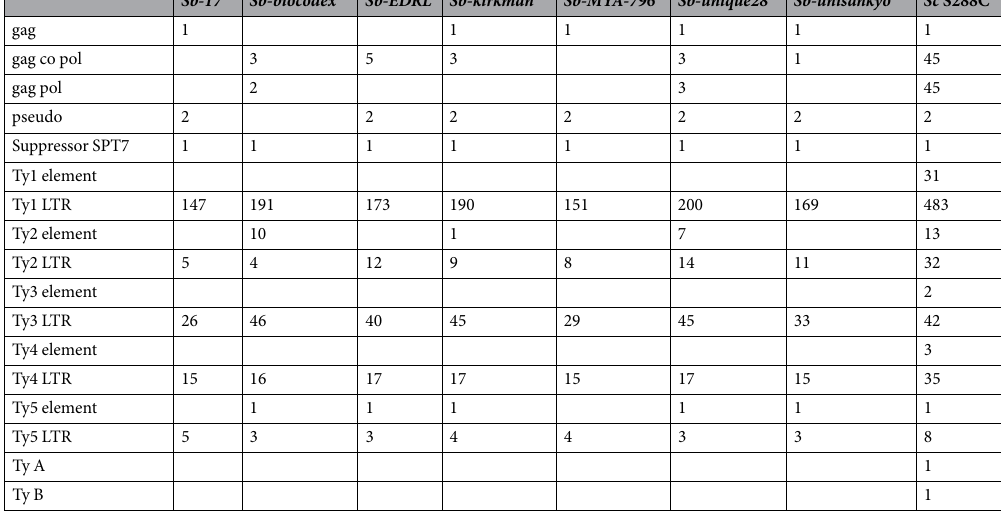
Table 4. Distribution of Ty elements in Sb strains.